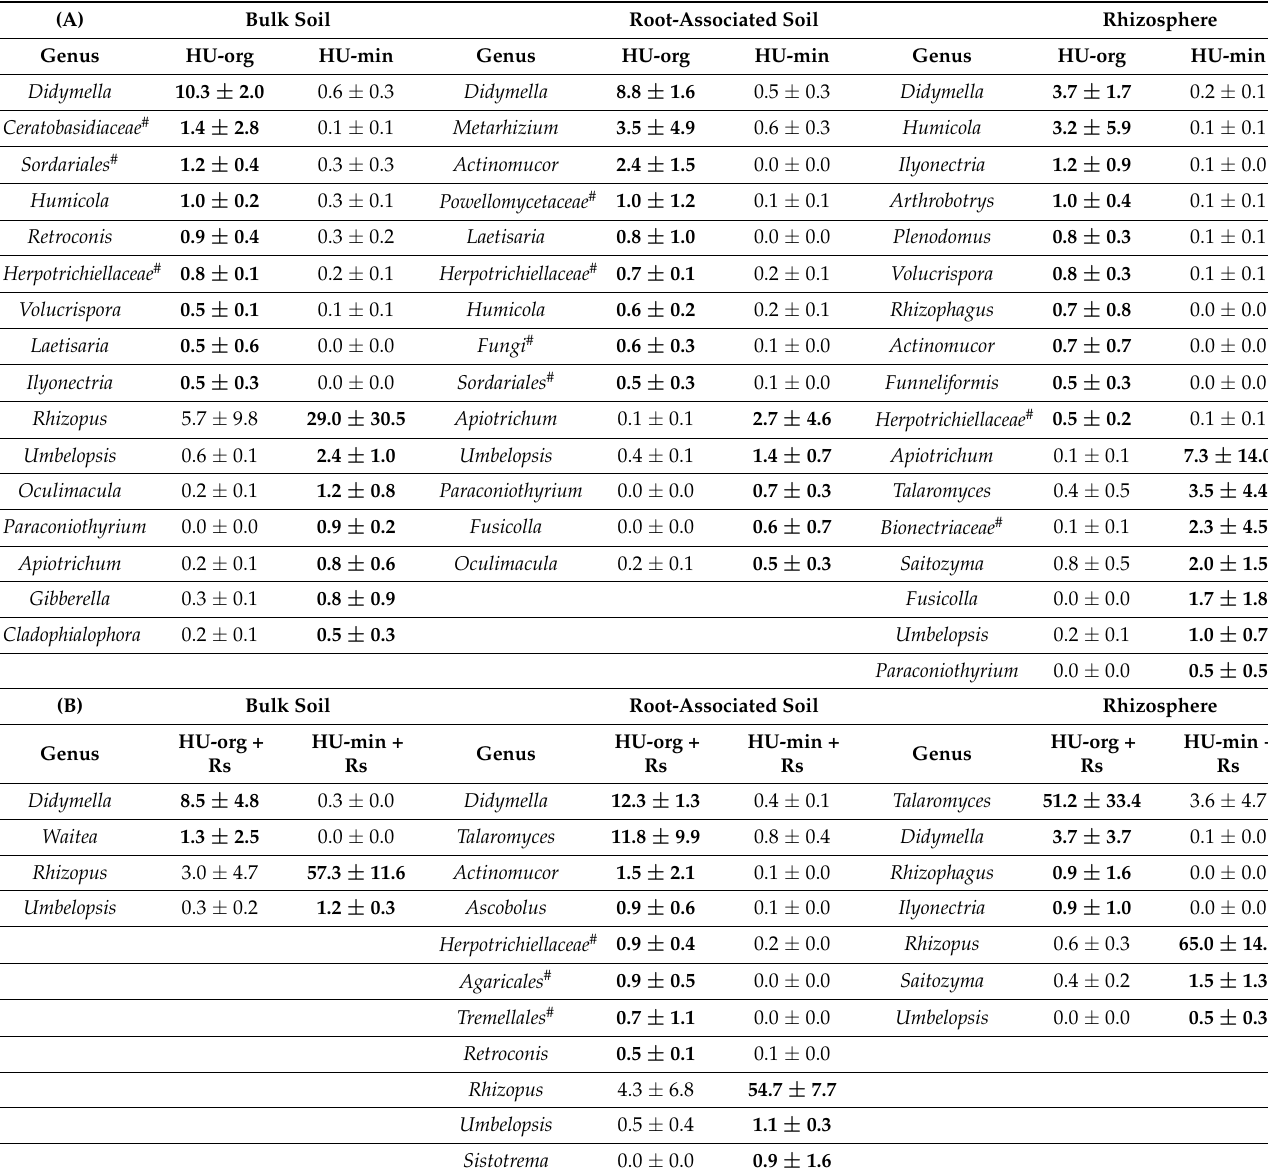
Table 5. Fungal genera in bulk soil, root-associated soil and the rhizosphere of lettuce (cv. Tizian) differing significantly (FDR < 0.05) in relative abundance depending on long-term organic (HU-org) and mineral (HU-min) fertilization strategy ( A ) in the absence and ( B ) in the presence of Rhizoctonia solani AG1-IB (Rs). Mean ± standard deviation of taxa with >0.5% relative abundance is displayed. Bold numbers indicate significant